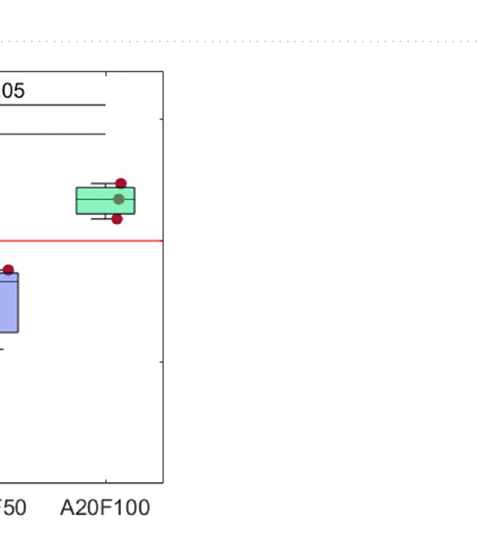
Figure 2. MC3T3-E1 cell survival at 72 h. The average number of implant-adherent cells at 16 h preculture (~ 24,600 cells per implant) is taken as 100% survival at 0 h. Ctrl, n = 5; A10F50, A20F50, and A20F100, n =